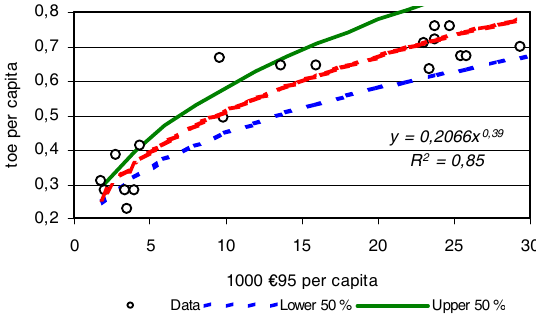
Fig 9. Dependence function of relative consumption of petroleum products in road transport (PPt) on GDP per